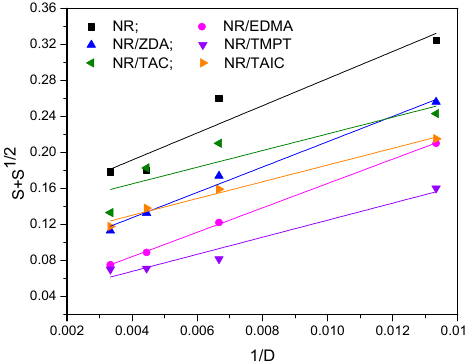
Figure 7. Charlesby–Pinner plots of NR and NR/PFMs samples.